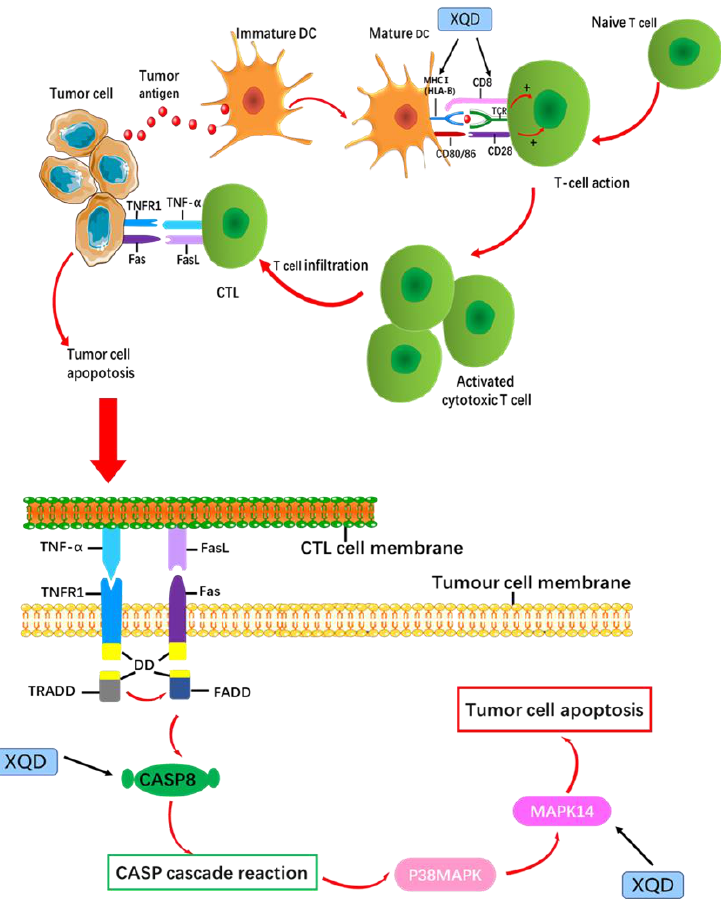
Figure 7. The target of XQD for LC therapy regulates immune-mediated tumor cell apoptosis. DC, dendritic cell; MHC, Major histocompatibility complex, TCR, T-cell receptor, CTL, Cytotoxic T cells, DD, Death domain, FADD, Fas-associated death domain, TRADD, TNF receptor associated death domain. HLA-B, CASP8 and MAPK14 were three therapeutic targets of XQD for LC.